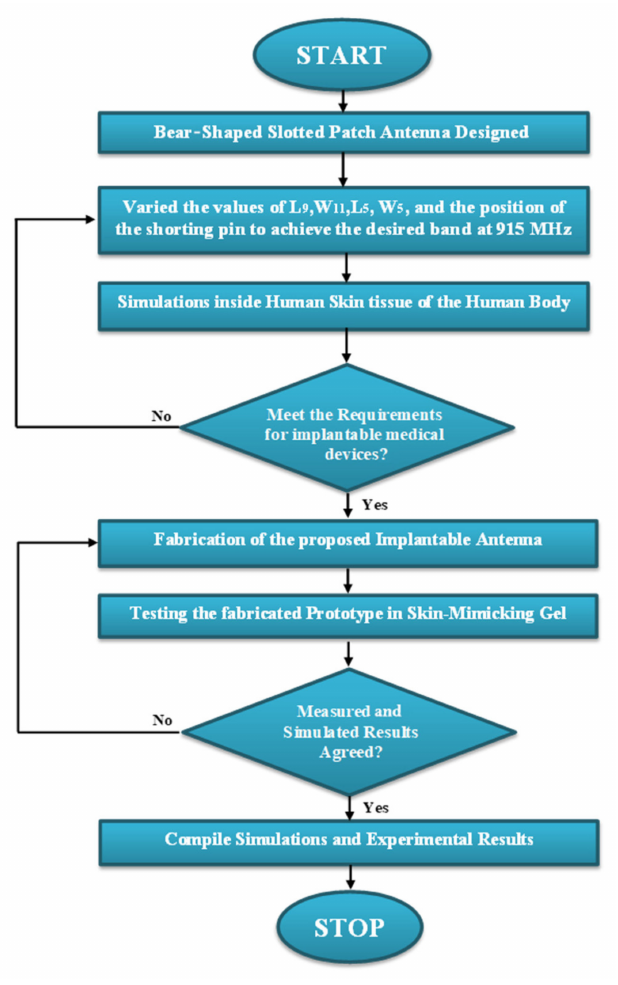
Figure 5. Basic design process of the Beas-shaped patch implantable